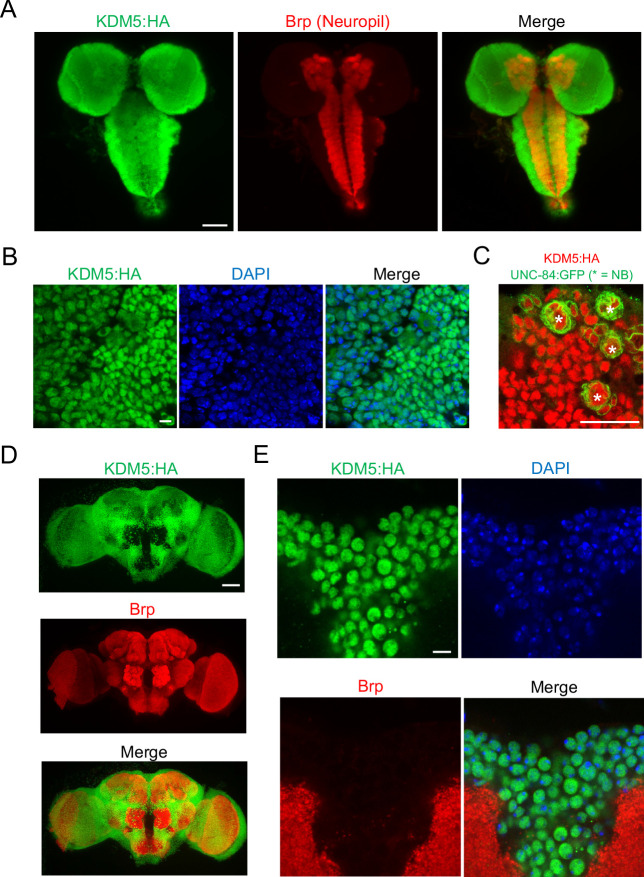
lysine demethylase 5 (KDM5) is broadly expressed in nuclei of the Drosophila larval central nervous system (CNS) and adult brain.(A) Maximal Z projection of third-instar larval CNS revealing broad expression of endogenously tagged KDM5:HA and stained with anti-HA and anti-Bruchpilot (anti-Brp). (B) Cortical region of a larval (WL3) brain lobe stained with anti-HA and DAPI, showing nuclear localization of endogenously tagged KDM5:HA. (C) Neuroblast (NB)-specific wor-Gal4 driving expression of UNC-84:GFP to demonstrate endogenously tagged KDM5:HA expression within nuclei of WL3 central brain NBs (marked by *) and presumptive ganglion mother cells. UNC-84:GFP perdures for approximately 2–3 cell divisions. (D) Maximal Z projection of an adult brain revealing broad expression of endogenously tagged KDM5:HA with anti-HA and counterstained for neuropil with anti-Brp. (E) Dorsoanterior cortical region of an adult brain with endogenously tagged KDM5:HA. The nuclear localization of KDM5:HA is revealed by anti-HA, DAPI, and anti-Brp staining. Scale bars represent 50 μm in (A) and (D), 5 μM in (B) and (E), and 20 μM in (C).